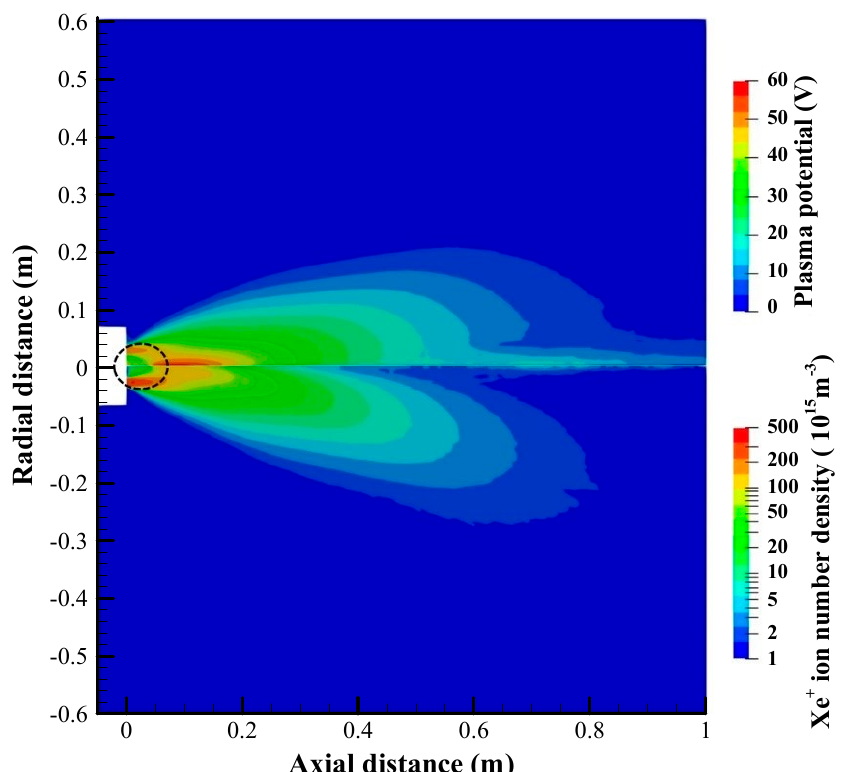
Figure 9. Contours of the plasma potential (top) and Xe + ion number density (bottom) for Case 1 without CEX effects.